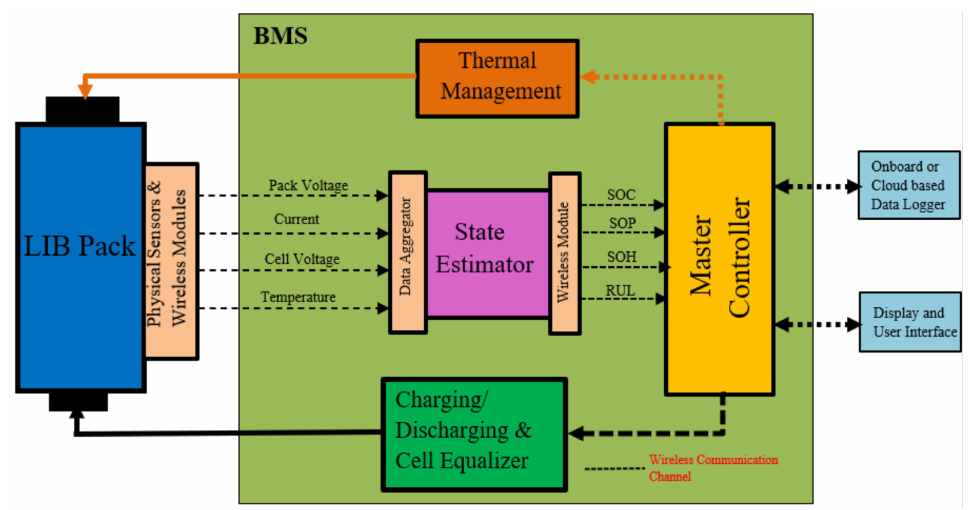
Figure 1. Schematic layout of a generic WBMS.